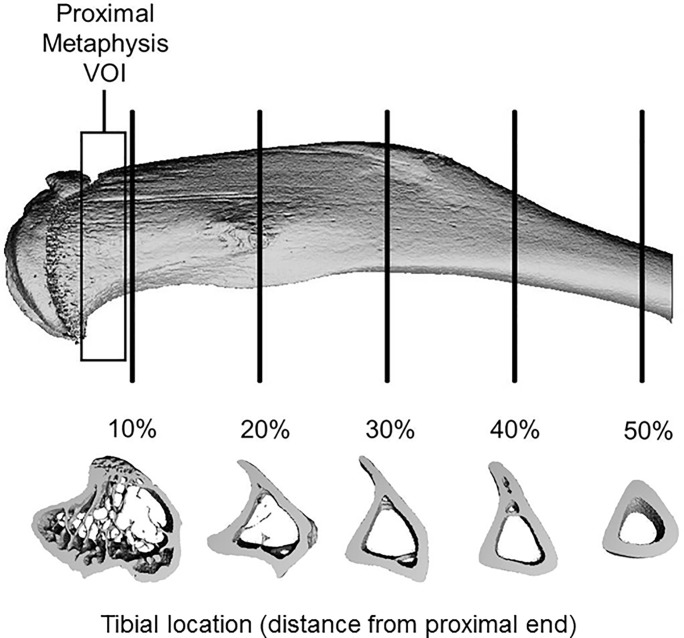
Regions of interest for analysis of trabecular and cortical bone.MicroCT analysis of trabecular bone was performed at the proximal tibial metaphysis. Cortical bone analysis was performed using μCT and dynamic histomorphometry at 5 locations along the length of the tibias.